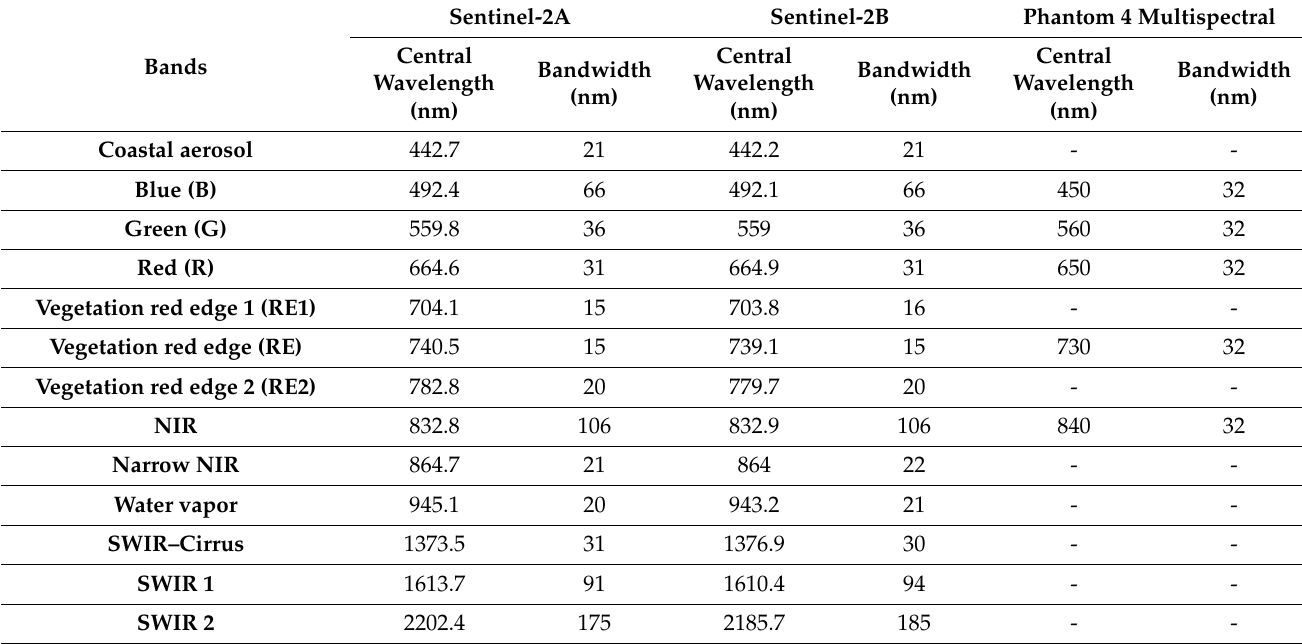
Table 2. Spectral characteristics of the remote sensors used in the